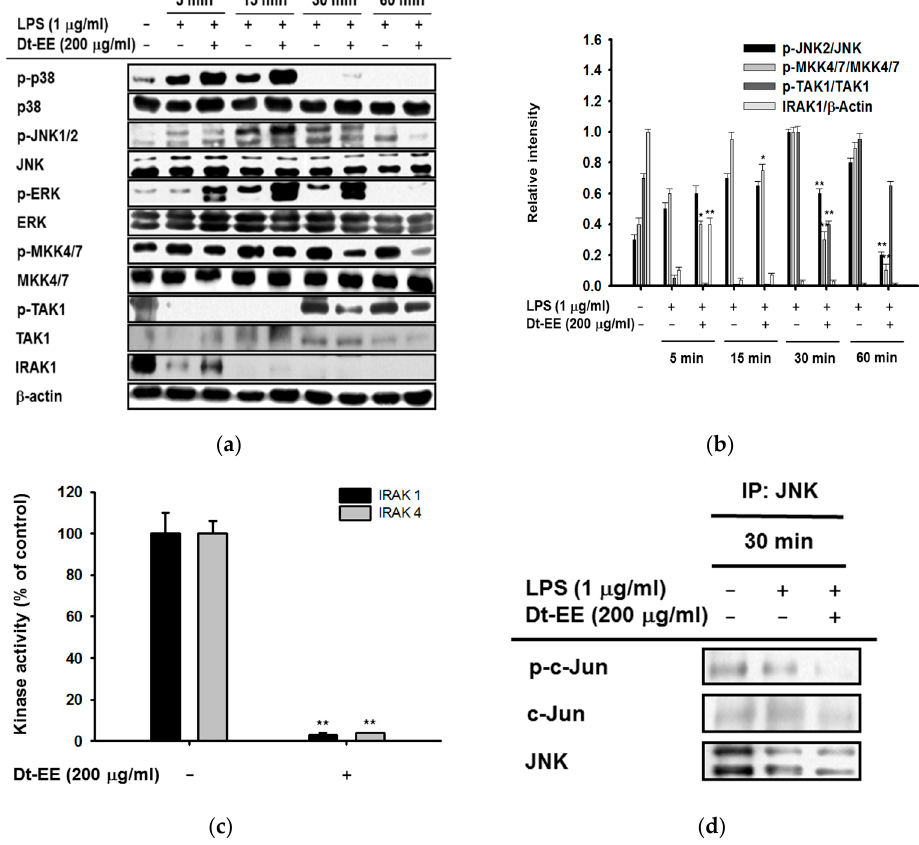
Figure 3. Effect of Dt-EE in activating the AP-1 pathway. ( a ) The total and phosphorylated proteins of the AP-1 pathway (p38, JNK1/2, ERK, MKK4/7, TAK1, and IRAK1) and β -actin were detected by western blotting analyses. ( b )The band intensities were calculated using ImageJ. ( c ) The kinase activities of IRAK1 and IRAK4 were measured by a kinase profiler service from Millipore. ( d ) The binding levels of JNK and c-Jun were detected in whole cell lysates by immunoprecipitation with anti-JNK and immunoblotting with antibodies to p-c-Jun, c-Jun, and JNK. *: p < 0.05 and **: p < 0.01 compared to the induced group.